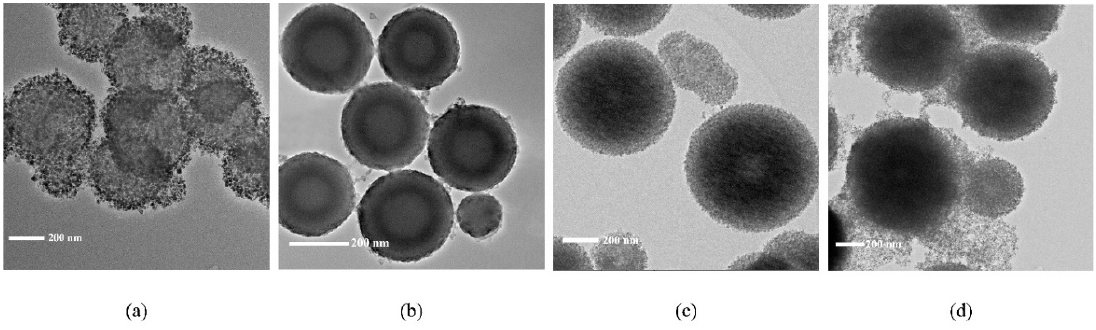
Figure 4. ( a ) PP@TiO 2 -25, ( b ) PP@TiO 2 -50, ( c ) PP@TiO 2 -75, and ( d ) PP@TiO 2 -100 TEM images.